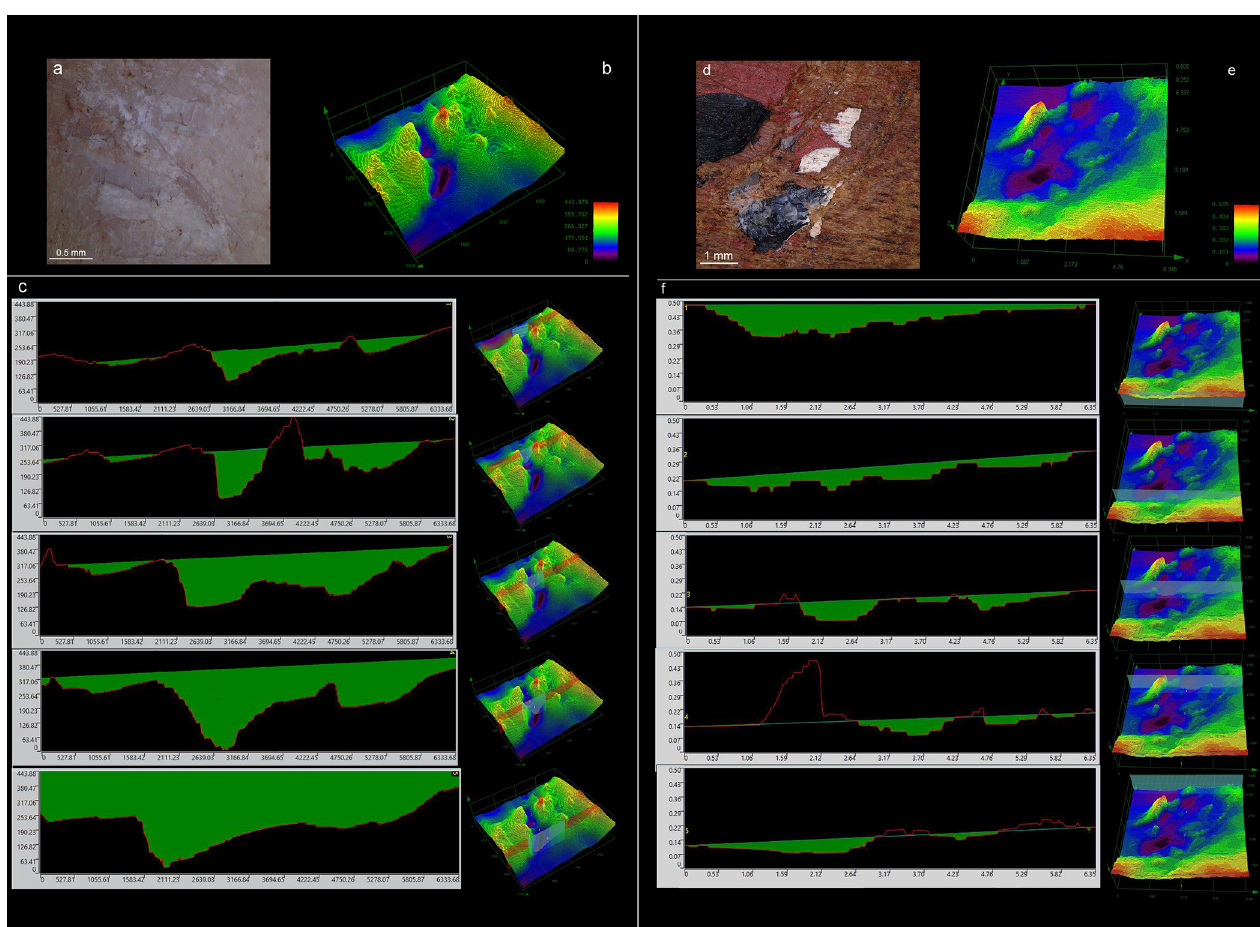
Fig 8. 3D analysis of a single notch on bone retoucher (left) and boomerang (right). (a) colour 2D image of the notch on bone retoucher (10x); (b) image of the same stigma with 3D height data; (c) profile measurements and cross-section internal surface measured in different portions of the notch on bone retoucher; the analysis shows that the notch is composed of the superposition of linear and punctiform impressions, penetrating deeply in the bone surface. (d) Colour 2D image of the notch on boomerang (3x); (b) image of the same stigma with 3D height data; (c) profile measurements and cross-section internal surface measured in different portions of the notch on boomerang; the analysis shows that the notch is composed of the superposition of linear and punctiform impressions, penetrating very deeply in the wooden